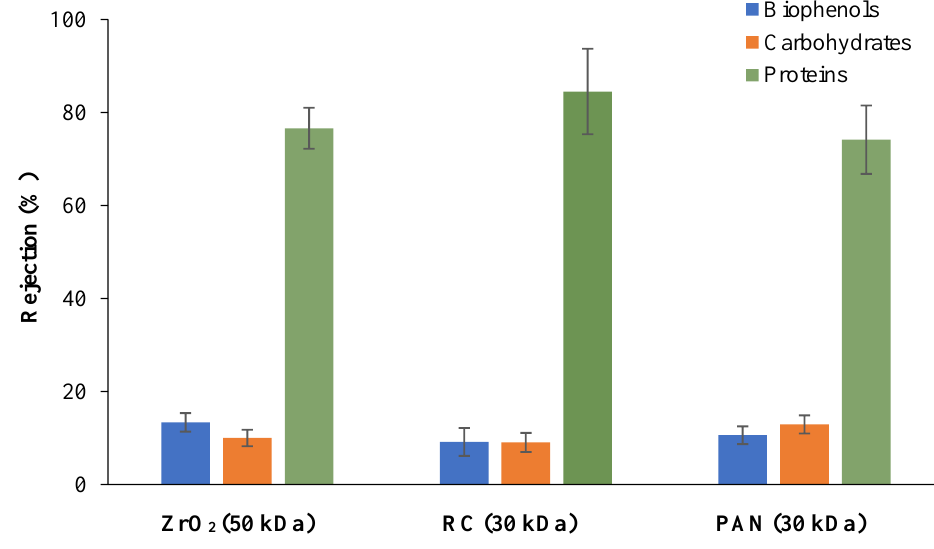
Figure 4. Rejection of membranes towards main biomolecules.